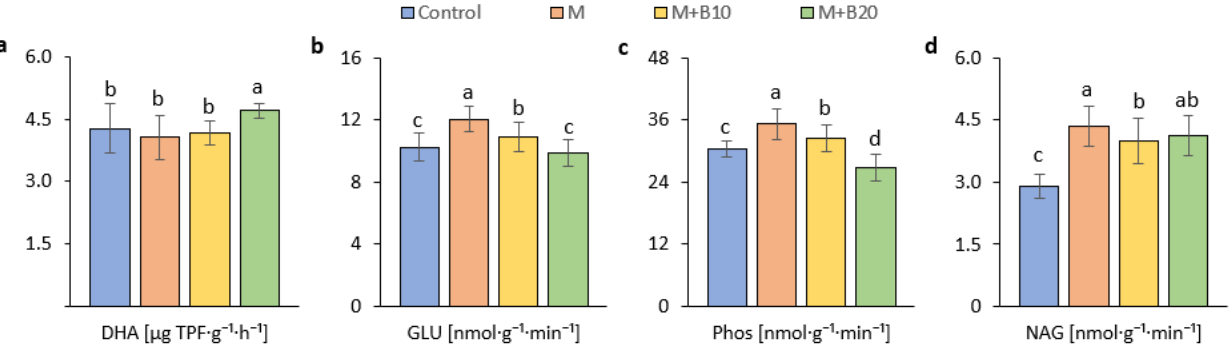
Figure 2. The effects of different amendments on: ( a ) dehydrogenase activity; ( b ) β -glucosidase activity; ( c ) phosphatase activity; and ( d ) N -acetyl- β - D -glucosaminidase. Different lowercase letters represent statistical difference at p = 0.05, ( n =